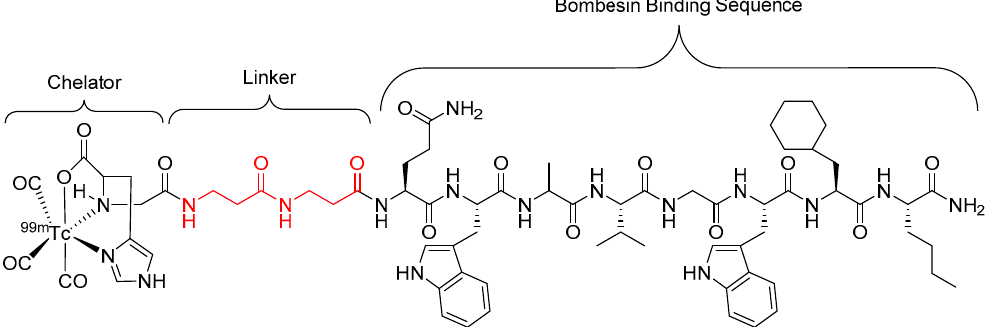
Figure 9. Bombesin-based peptide radiopharmaceutical investigated by Garayoa et al . , with the β Ala– β Ala linker highlighted in red [81].